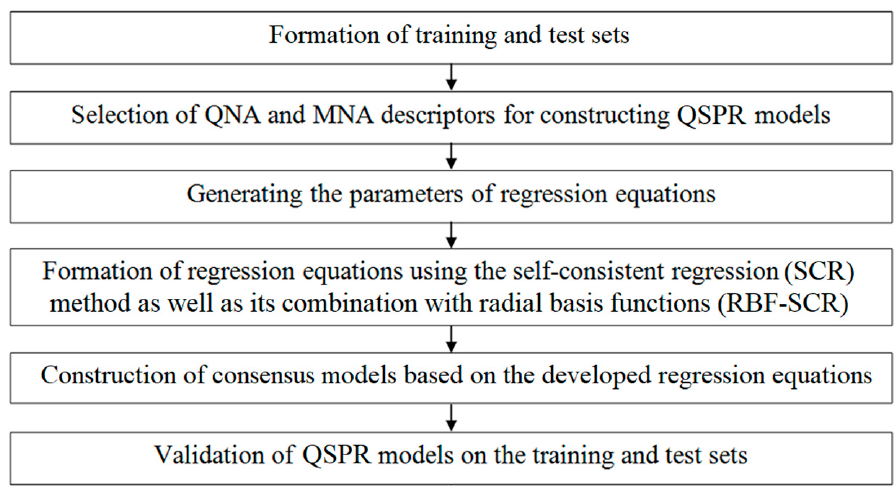
Figure 8. Schematic representation of the GUSAR algorithm.